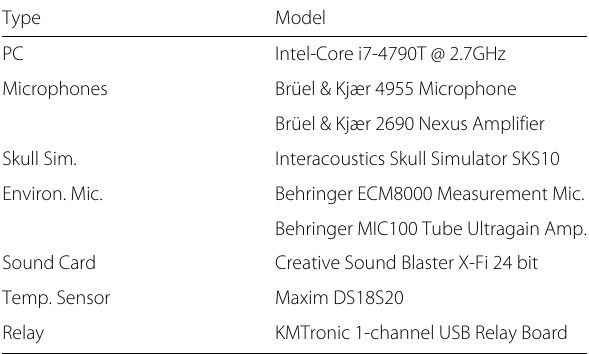
Table 2 Hardware components constituting the artificial